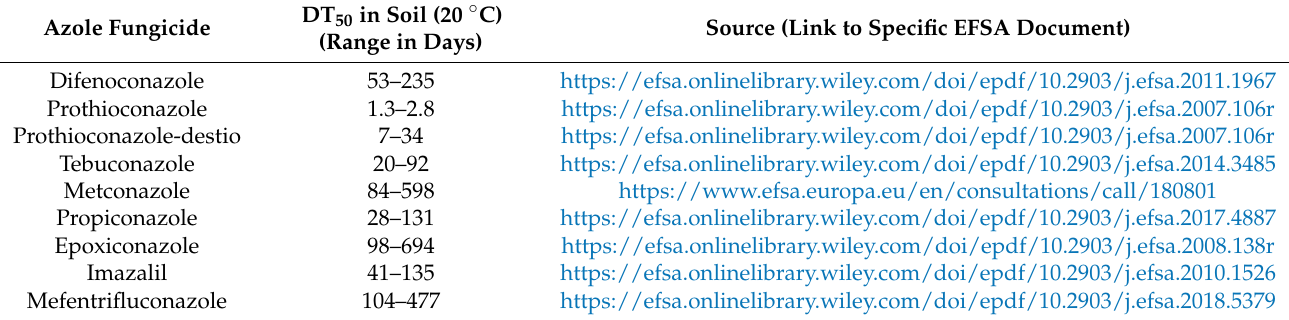
Table 3. Comparison of azole degradation times (DT 50 (half-life)) in soil as given in EFSA summary reports. DT 50 in Soil (20 ◦ C) Azole Fungicide (Range in